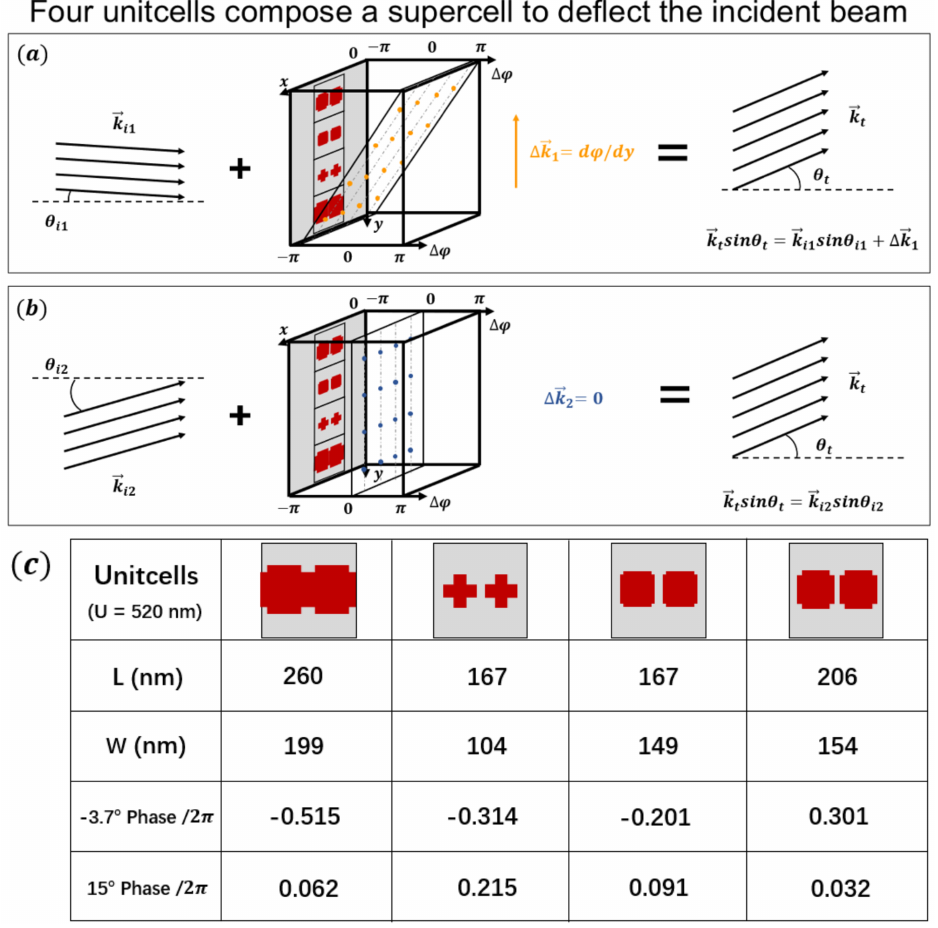
Figure 6. Working principle of the metasurface combiner under different incident angles. Four unitcells compose a supercell (a single period of the gradient metasurface) to deflect the incident beam. The length of the supercell is 2080 nm. ( a ) Light goes through an abnormal refraction; ( b ) Light goes through normal refraction; ( c ) The four unitcells we used in the metasurface combiner design. The parameters of the four unitcells we used in this design are given in Figure